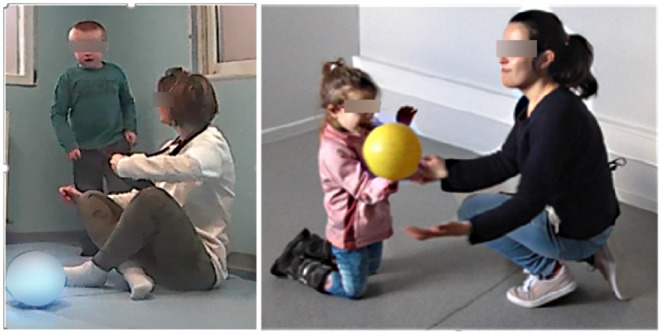
Intervention conditions: with robot (left) and with ball (right).